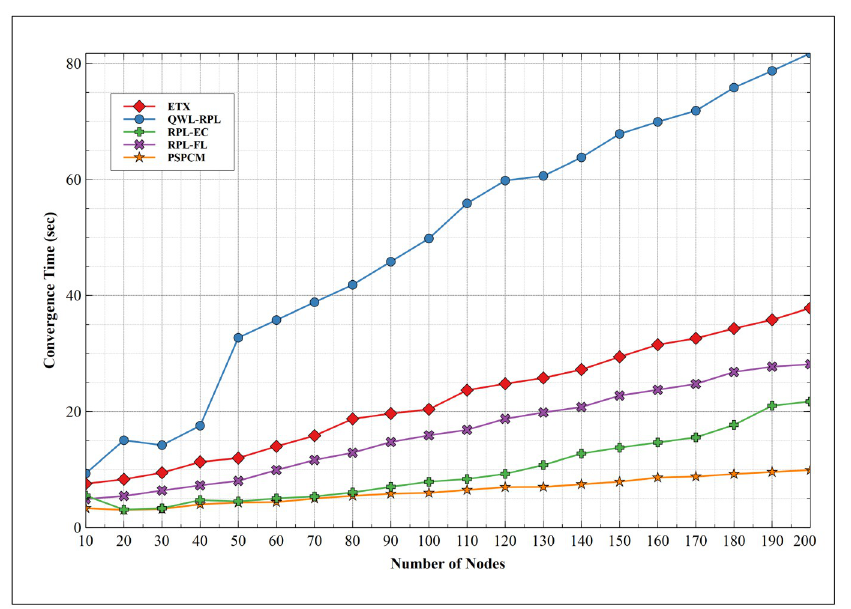
Fig 19. Convergence